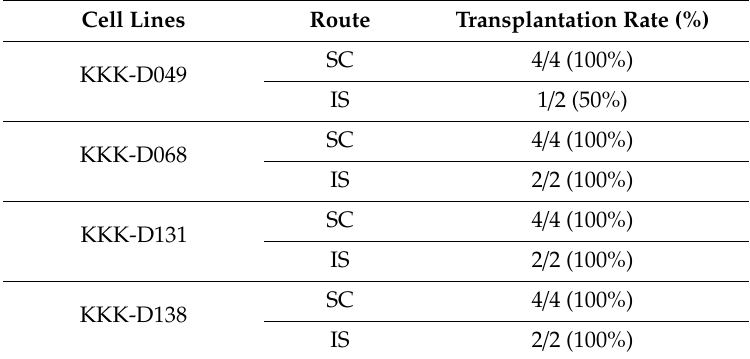
Table 3. PDX-derived cell line transplantation rate in subcutaneous (SC) and intrasplenic (IS) xenograft mouse model.